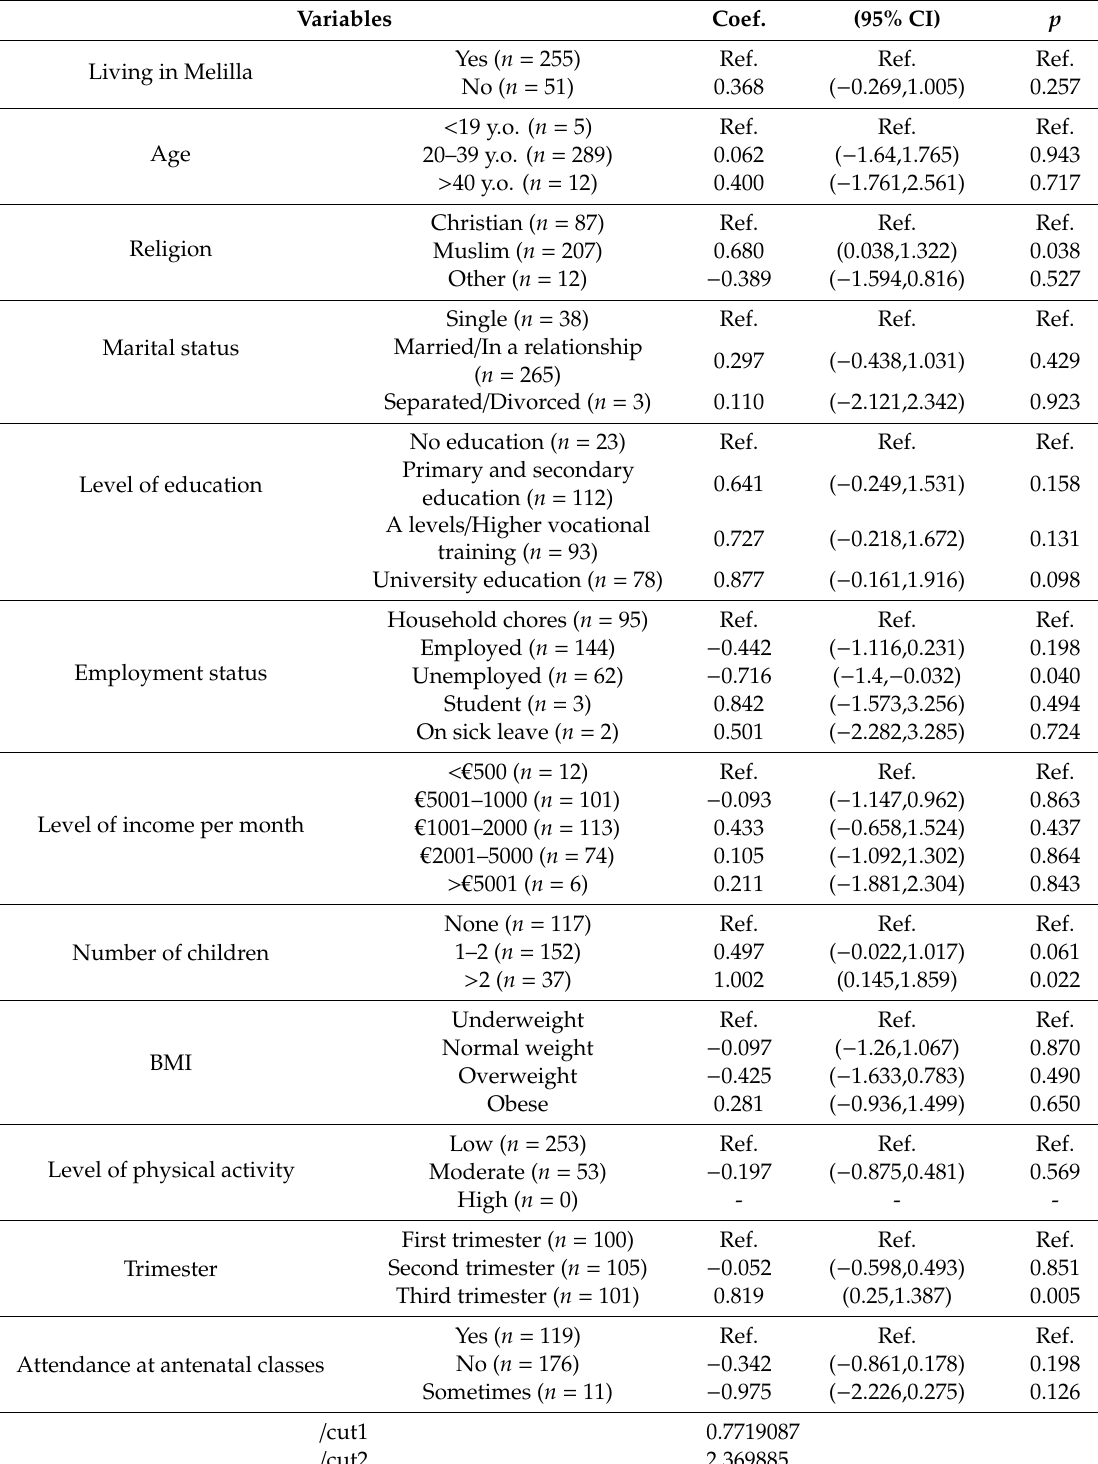
Table 6. Sociodemographic, lifestyle-related, and pregnancy-related variables and dietary patterns during pregnancy: ordinal linear regression model ( N = 306)